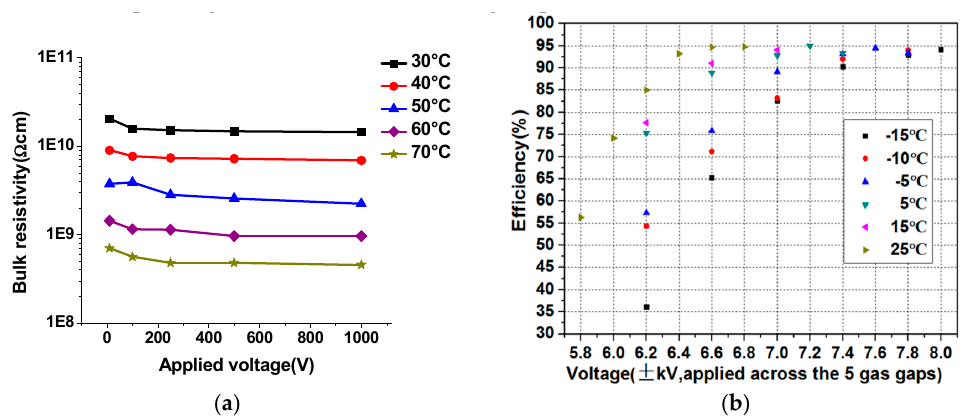
Figure 17. ( a ) The bulk resistivity of the low resistivity glass changes with temperature. ( b ) Efficiency versus applied voltage at different temperatures. Reproduced with permission from Chen et al., Journal of Instrumentation; published by IOP Publishing for Sissa Medialab, 2018 [109].